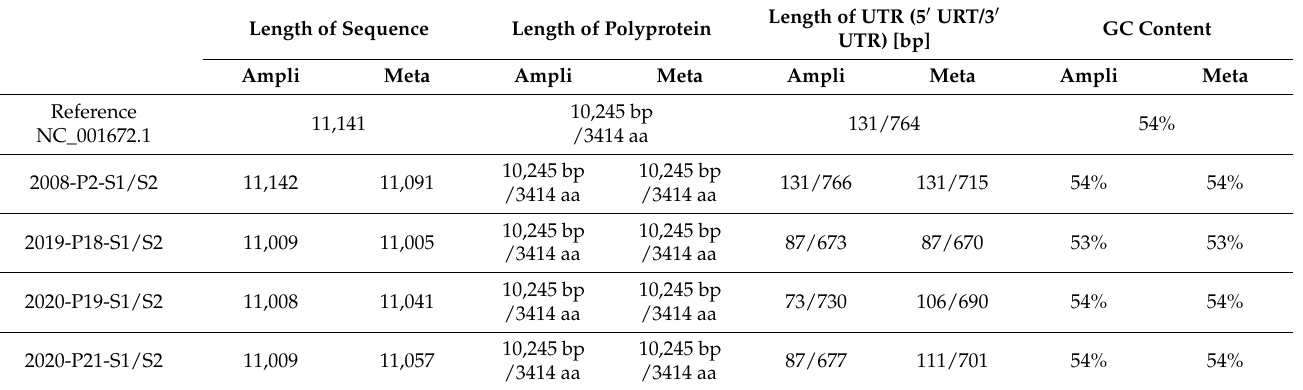
Table 2. Comparison of consensus sequences generated from the same sample using the amplicon- based or shotgun metagenomic approach and comparison to the reference genome with accession number NC_001672.1. (Abbreviations: aa = amino acids, bp = base pairs, UTR = untranslated